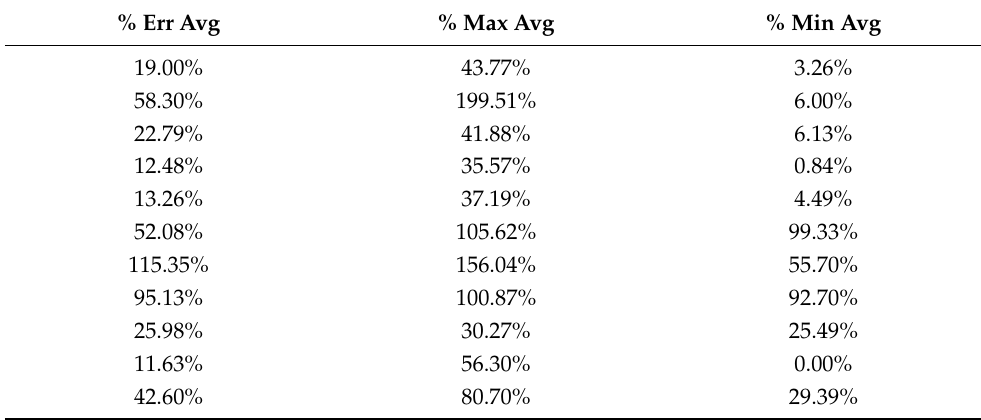
Table A90. Set 2, trials 1–10 data (average actual PR